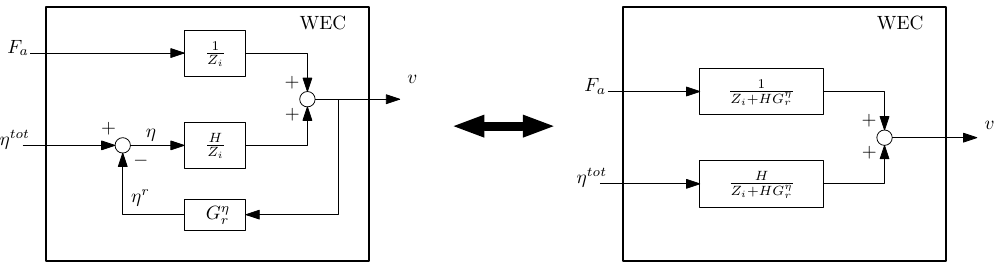
Figure 9. The diagram in Figure 8 can be rearranged as a two input system where the total surface elevation is considered as an input.